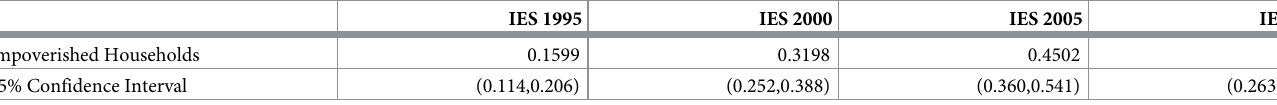
Table 3. Impoverishment arising from out-of-pocket health care